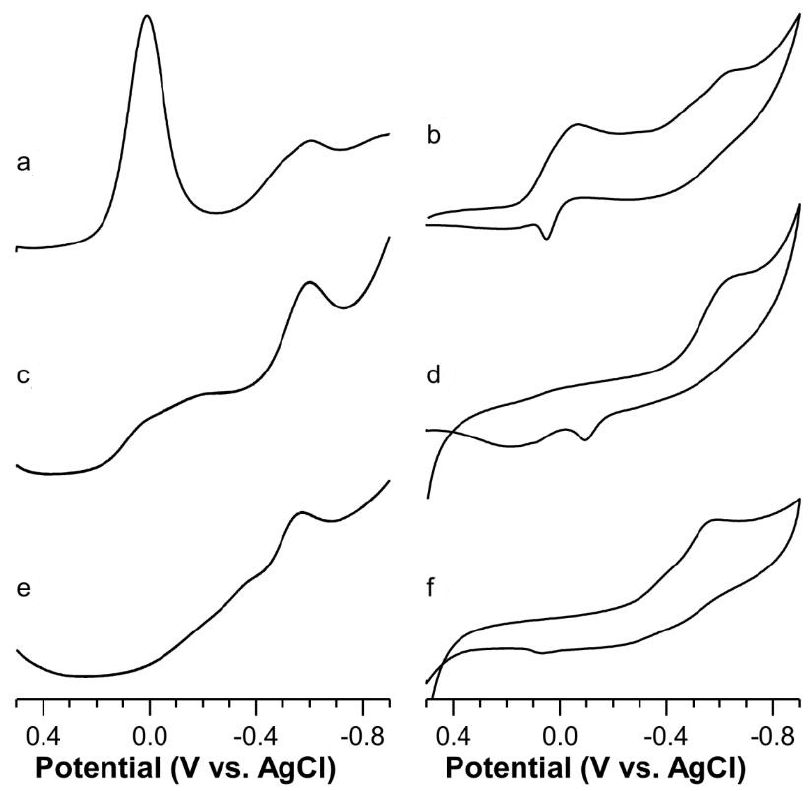
Figure 5. Square wave (left) and cyclic (right) voltammograms of Cu(II)-Ang1-17 system (C L = 5 × 10 −4 M, M:L 0.9:1, KNO 3 0.1 M) in aqueous solution as function of the pH: ( a , b ) 4.5; ( c , d ) 7.3; ( e , f )